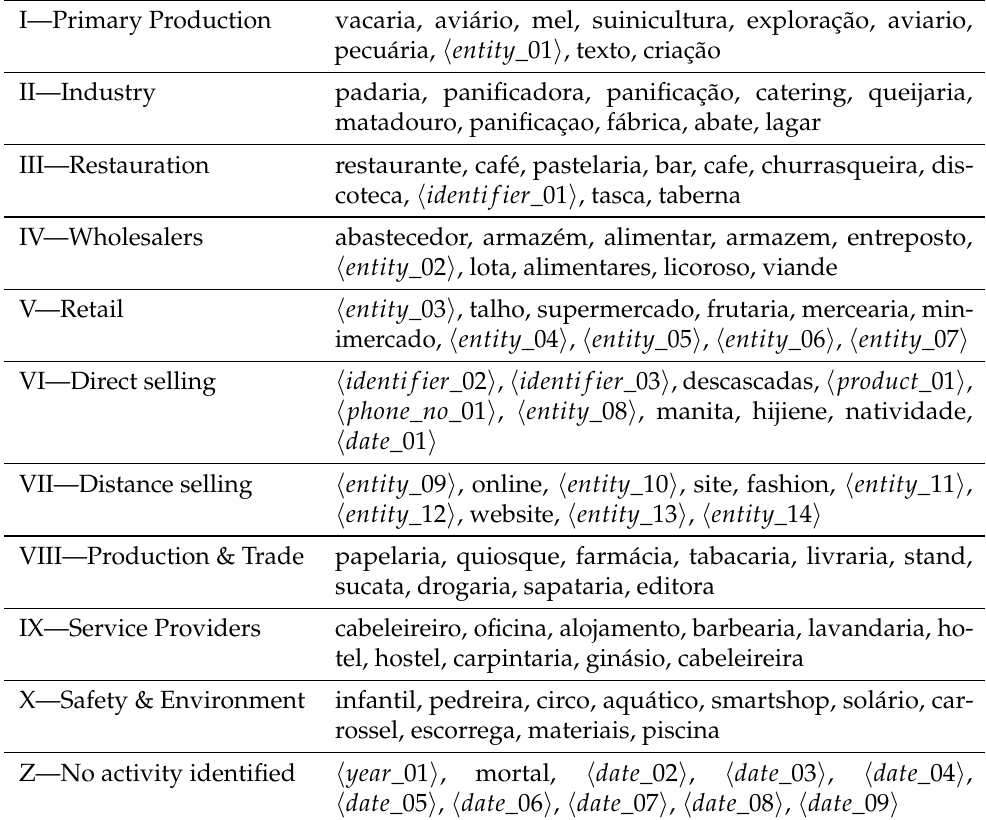
Table 11. Top-10 features for economic activity prediction using the base techniques with SVM.